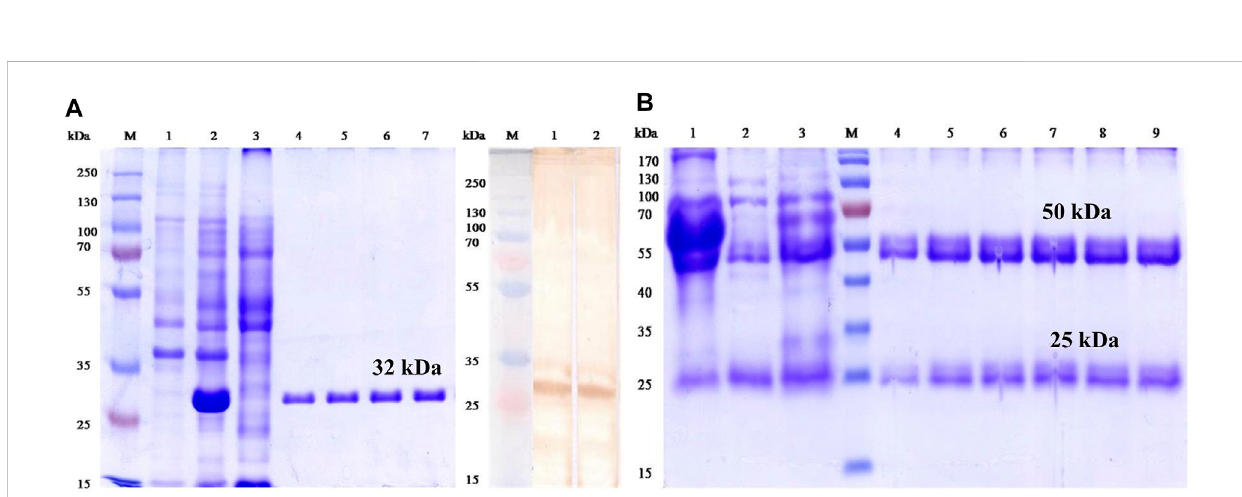
FIGURE 9 First-dimension SDS-PAGE and immunoblot analysis of rOmp28 Ag and IgG-pAbs, respectively, with (A) characterization of the expressed and puri fi edrOmp28proteinof Brucellamelitensis 16MusingSDS-PAGEshowingthepuri fi edrecombinantproteinof32 kDa(molecularweight)withoutany impurity.PAGEanalysiswithun-induced( Escherichiacoli ,BL-21clone)lysate(Lane1),1 mMIPTGinduced(BL-21)clonefor5 h(Lane2),Ni-NTAagarose column fl ow through (Lane 3), puri fi ed rOmp28 protein elutes 1 to 4 (Lane 4 to 7) in 8M urea at denaturing conditions, Lane M with Fermentas #SM1811 protein marker, and characteristic immunoblot analysis of the speci fi c immuno-reactivity of rOmp28-derived mice IgG pAbs showing positive immunoblot with Brucella melitensis 16M rOmp28-puri fi ed protein antigen (Lanes 1 and 2) and Lane M with Fermentas #SM1811 protein marker, respectively. (B) SDSPAGEanalysisofpuri fi edrOmp28miceIgGpAbsdevelopedagainsttherOmp28proteinantigenof Brucellamelitensis 16Mshowing crude mice polyclonal HIS (Lane 1), column wash and fl ow through (Lane 2 and 3), puri fi ed mice IgG pAbs elutes 1 to 6 (Lane 4 to 9) and Lane M